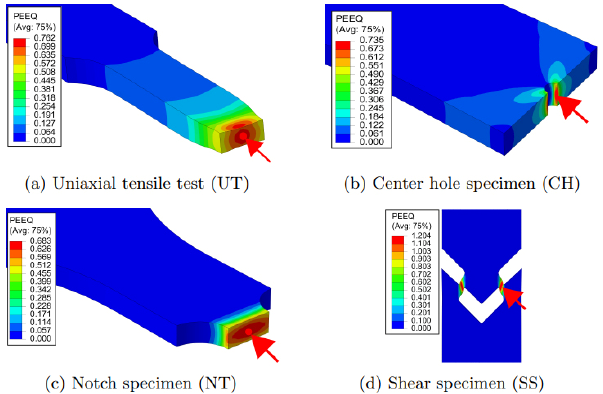
Fig. 4 Plastic strain distributions and locations of critical elements for (a) UT, (b) CH, (c) NT, and (d) SS specimens (the red dot marked symbol represents the location of critical element).